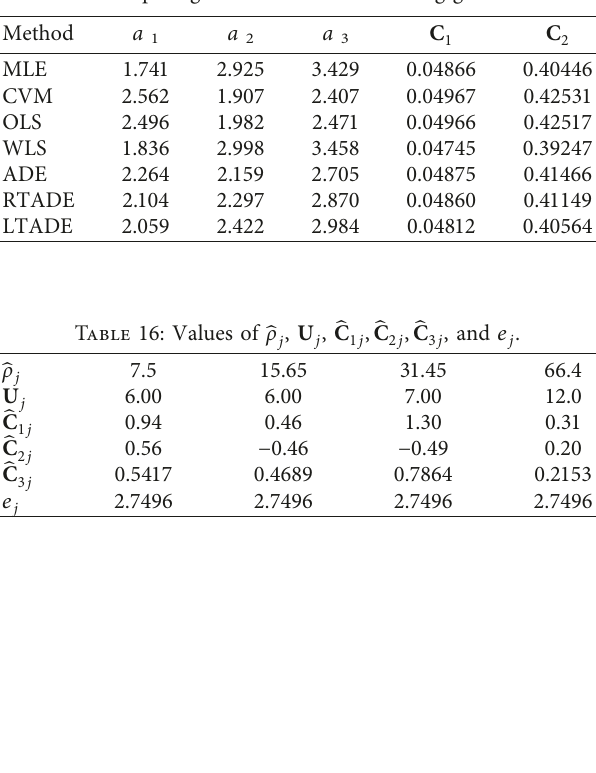
Table 15: Comparing estimation methods using glass fiber data.